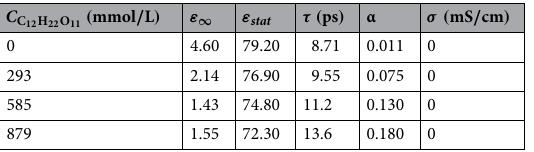
Table 2. Extracted Cole–Cole model parameters for sucrose/water